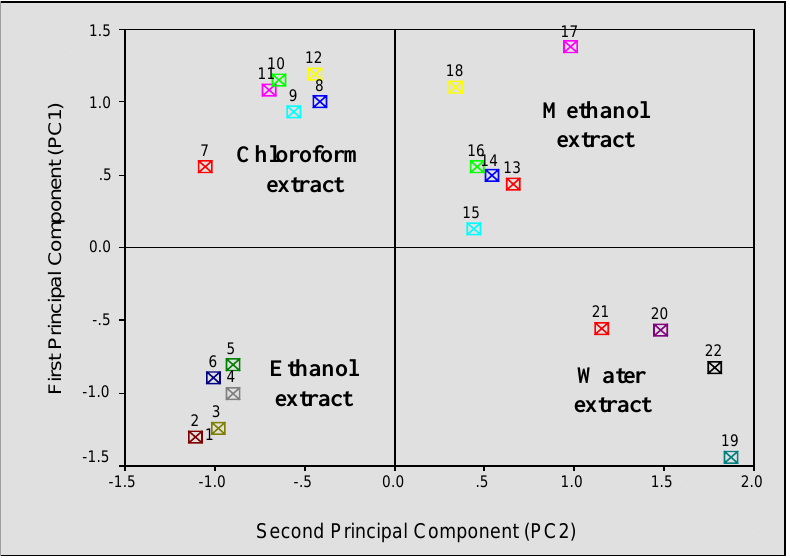
Figure 7. The scores plot of various solvent extract E. longifolia samples in two dimensional